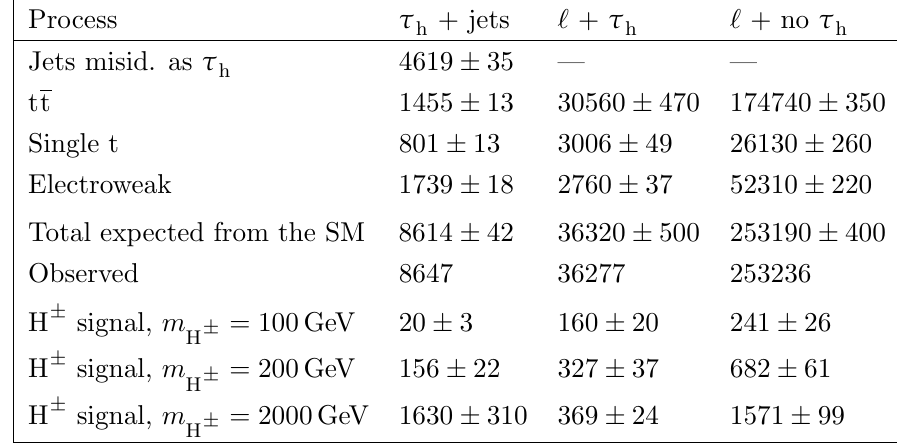
Table 3 . Number of expected and observed events for the three (cid:12)nal states after all selections, summed over all categories in each (cid:12)nal state. For background processes, the event yields after a background-only (cid:12)t and the corresponding uncertainties are shown. For the H (cid:6) mass hypotheses of 100, 200, and 2000 GeV, the signal yields are normalized to an H (cid:6) production cross section of 1 pb and the total systematic uncertainties (prior to the (cid:12)t) are